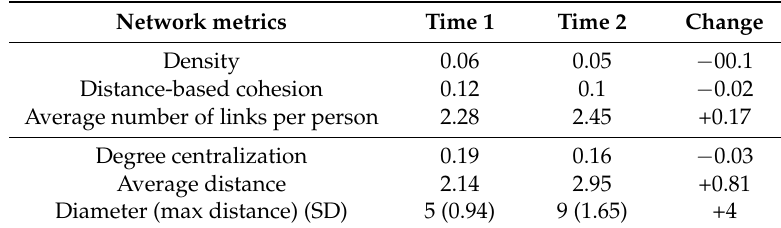
Table 2. Network-level metrics for support.